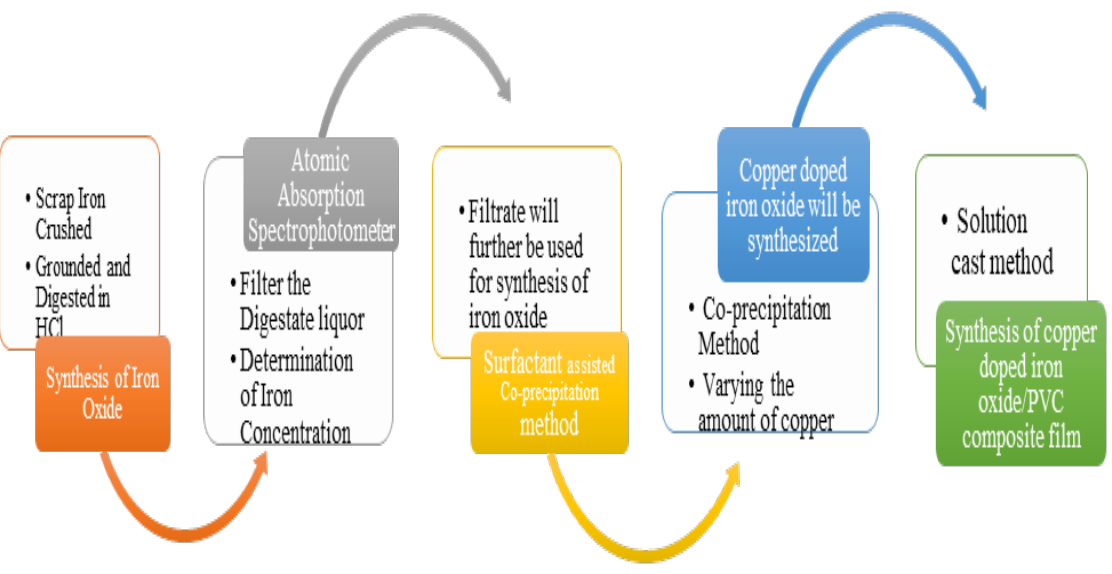
Figure 2. Flow sheet diagram of synthesis of Cu-doped iron oxide/PVC-composite films.